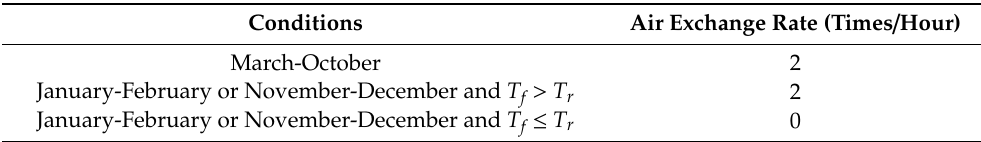
Table 2. Air exchange rates between the functional space and the tomb chamber.